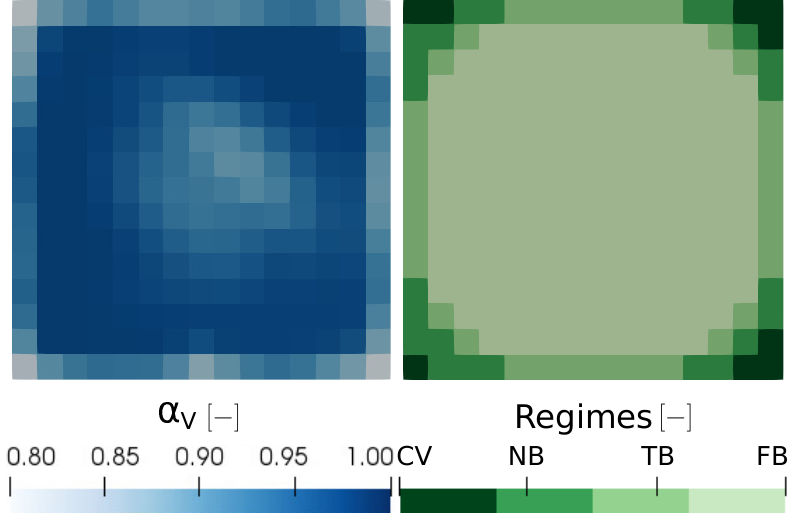
Figure 6. Vapour volume fraction and HTRs at the plate bottom for mesh z n = 3.1 mm at 18.2 s. The interfacial phase change is not activated. Regimes: CV—convective heat transfer, NB—nucleate boiling, TB—transition boiling, FB—film